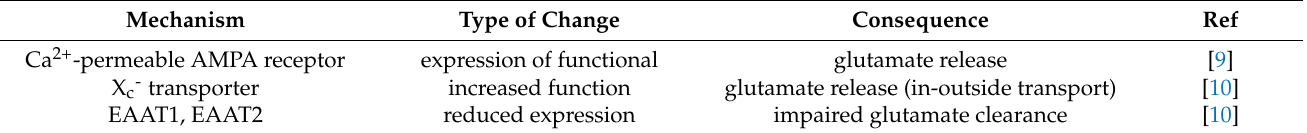
Table 1. Astrocyte-dependent mechanisms potentially contributing to excitotoxicity in Dach-SMOX mice. Mechanism Type of